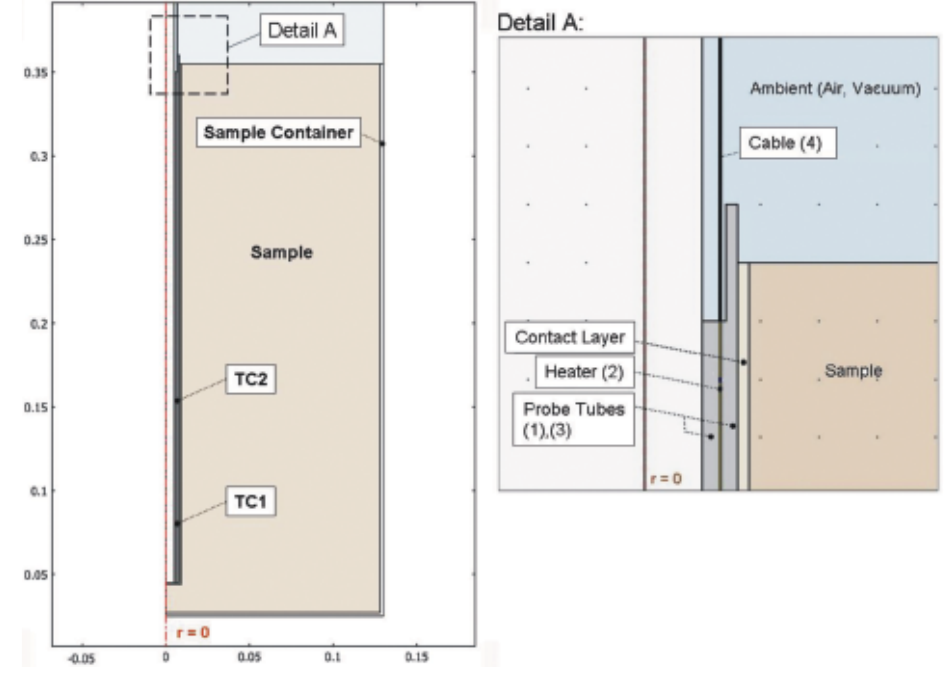
Fig. 12. Model of the LNP01-sensor embedded in a